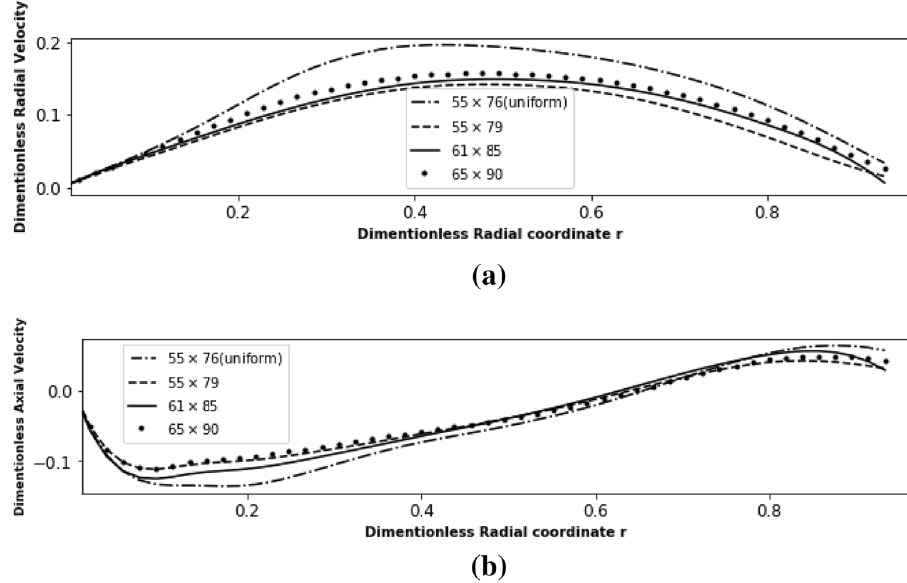
Fig. 2 Results for radial and axial velocity profiles with dif- ferent grid